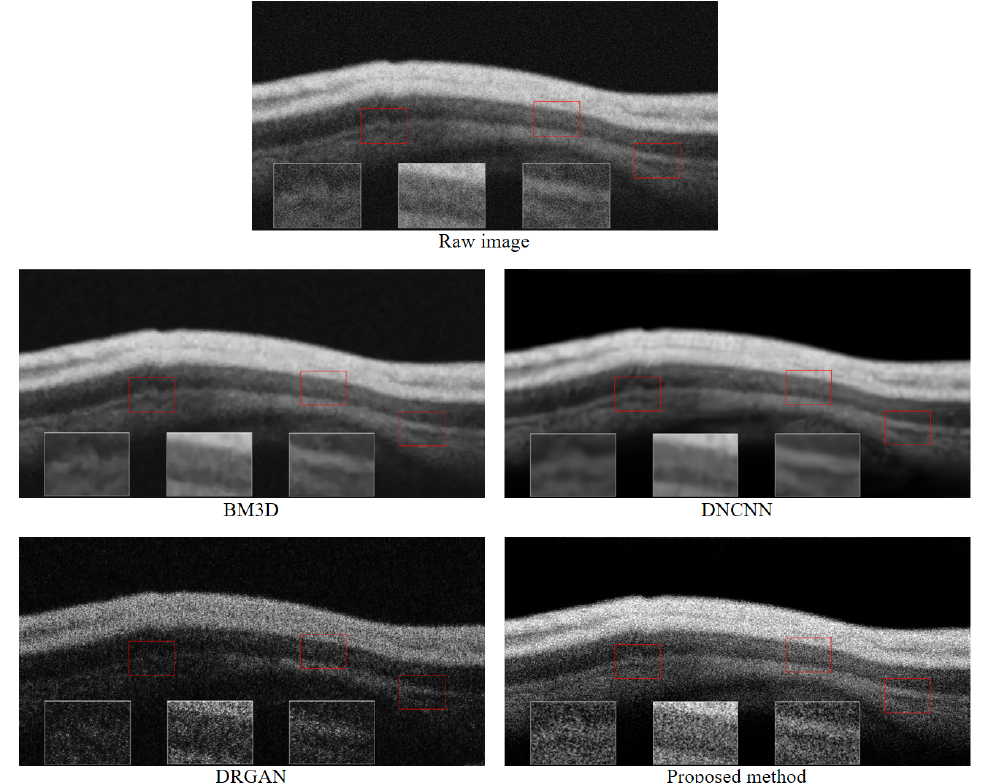
Figure 5. Sample images from the image enhancement performance study comparing the proposed OSE with the state of the art methods BM3D, DnCNN and DRGAN. The image areas marked in red are magnified and shown as inset pictures to facilitate the visual assessment of the different